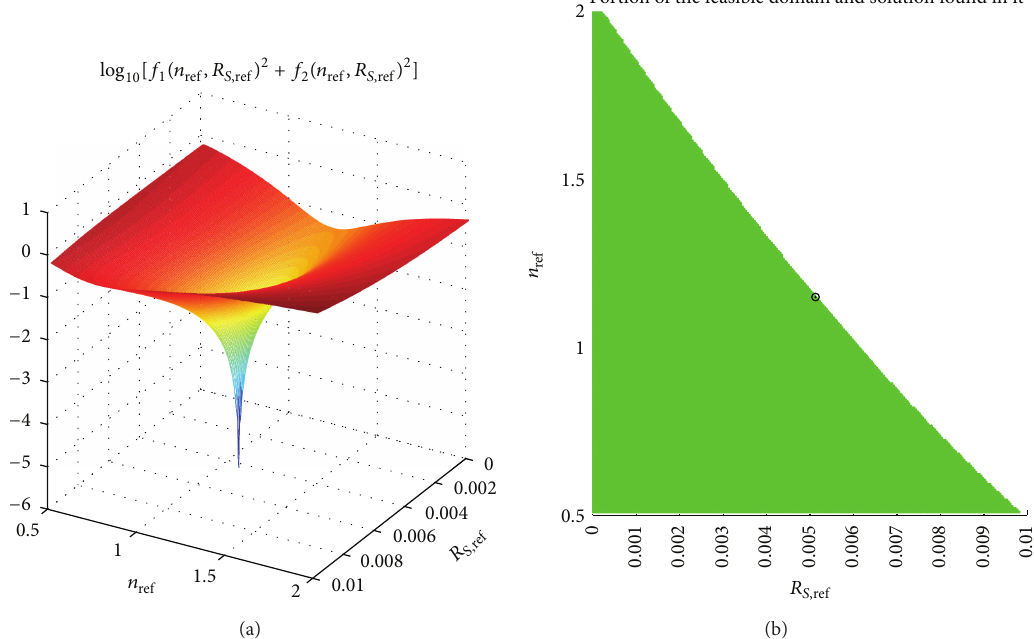
Figure 2: Graph of the functional (25) and the feasible domain for the BP 3 235 T PV panel (multi-Si technology). A unique physical solution